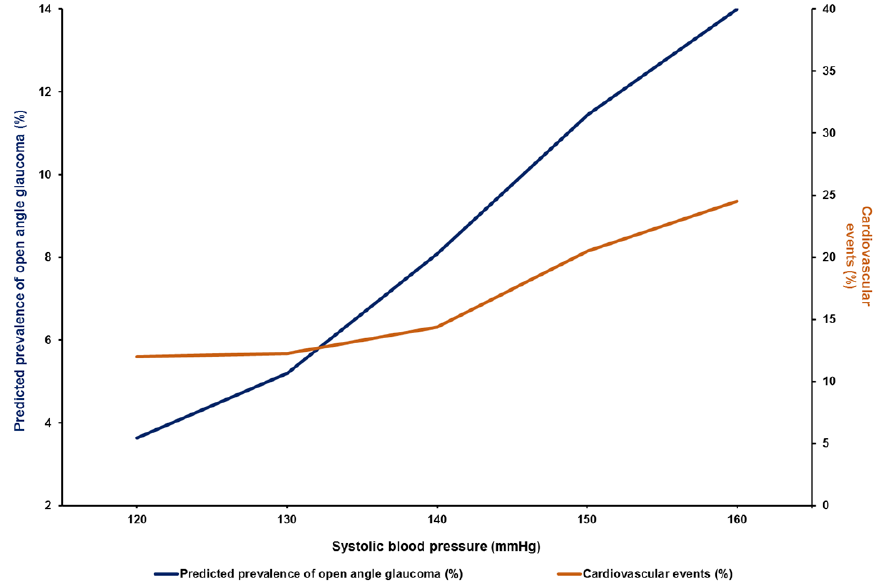
Figure 7. The relationship between SBP and the predicted prevalence of primary open angle glaucoma (POAG) in participants in the Los Angeles Latino Eye Study and cardiovascular events in the Ontarget study [50,75].